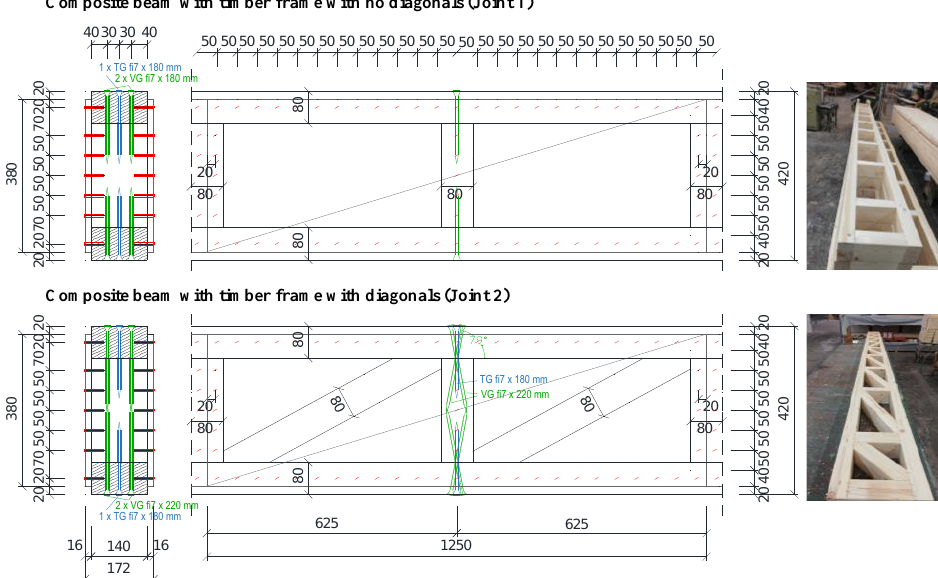
Figure 3. Cross-sections and side view cutouts (along longitudinal axes) of beams with cement-particle boards with details of stiffener – flange joints (in mm) and photos of constructed timber frames for beams with no diagonals (above) and beams with diagonals (bottom).